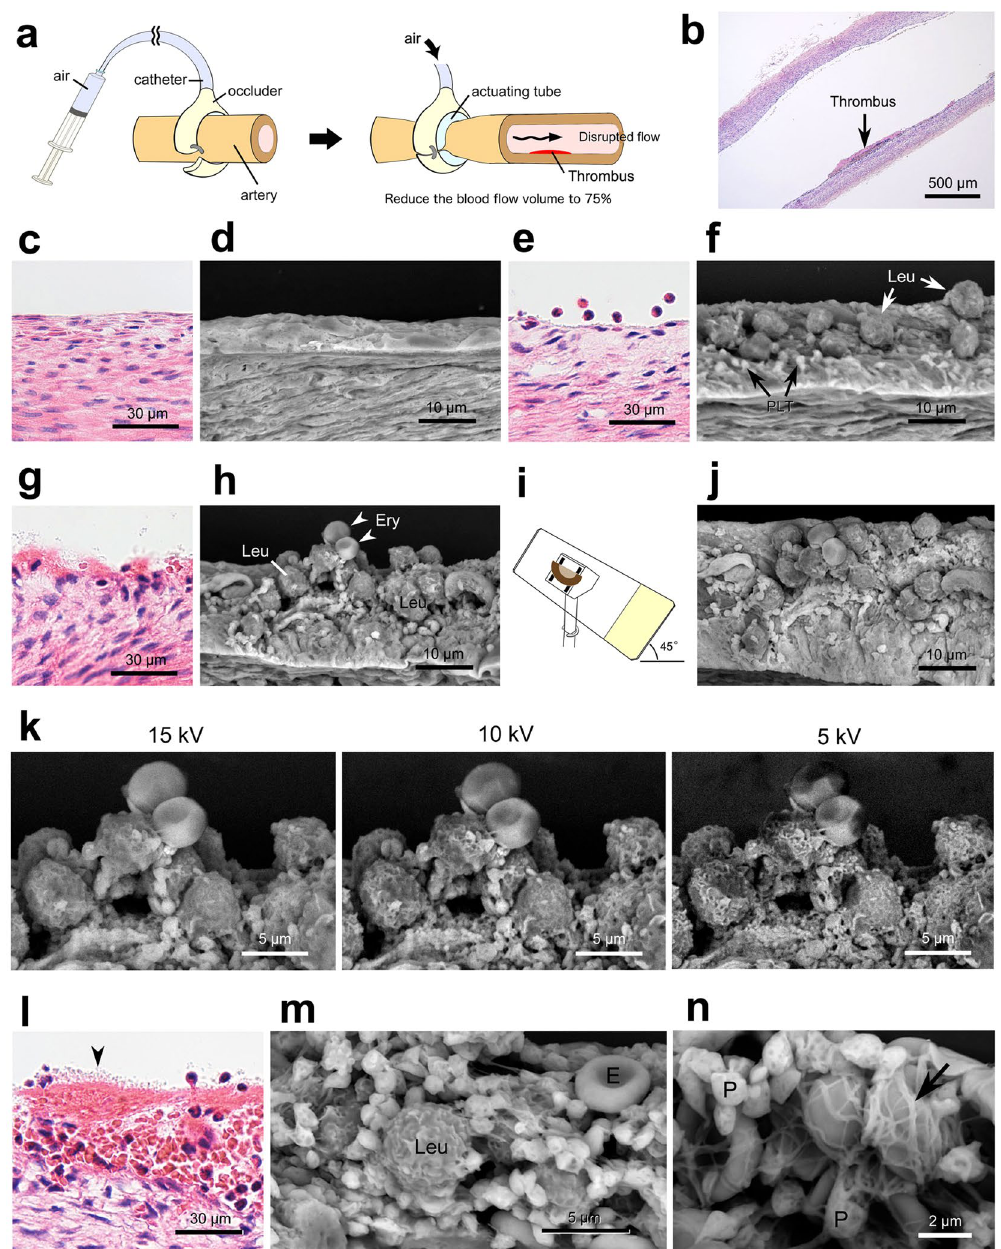
Figure 7. Application of Thick PS-LvSEM to pathological experiments. ( a – n ) An experimental model of thrombus formation induced by disturbing the blood flow in the rabbit femoral artery. All images were taken from 30 µ m sections, except the light micrographs from 5 µ m sections with H&E staining ( b , c , e , g , l ). ( a ) Illustration of the arterial blood flow disturbance. ( b ) Overview of the mural thrombus formation. ( c , d ) Normal endothelium. ( e , f ) Adhesion of leukocytes (Leu) and platelets (PLT) on the erosive endothelium. ( g – k ) Aggregations of leukocytes (Leu), erythrocytes (Ery), and platelets, attaching to the sub-endothelium exposed in close proximity to the thrombus. ( i ) Illustrated use of the optional 45° tilt-holder. ( j ) Tilted top view of the aggregation. ( k ) Comparison of accelerating voltages. Note the higher signal-to-noise ratio at 15 kV, and the surface configuration revealed at 5 kV. ( l – n ) Core portion of the mural thrombus consisting of erythrocytes (E), leukocytes (Leu), platelets (P, and arrowhead in l ), and fibrin fibres (arrow). ( n ) Note the network of fibrin fibres and platelets capturing the